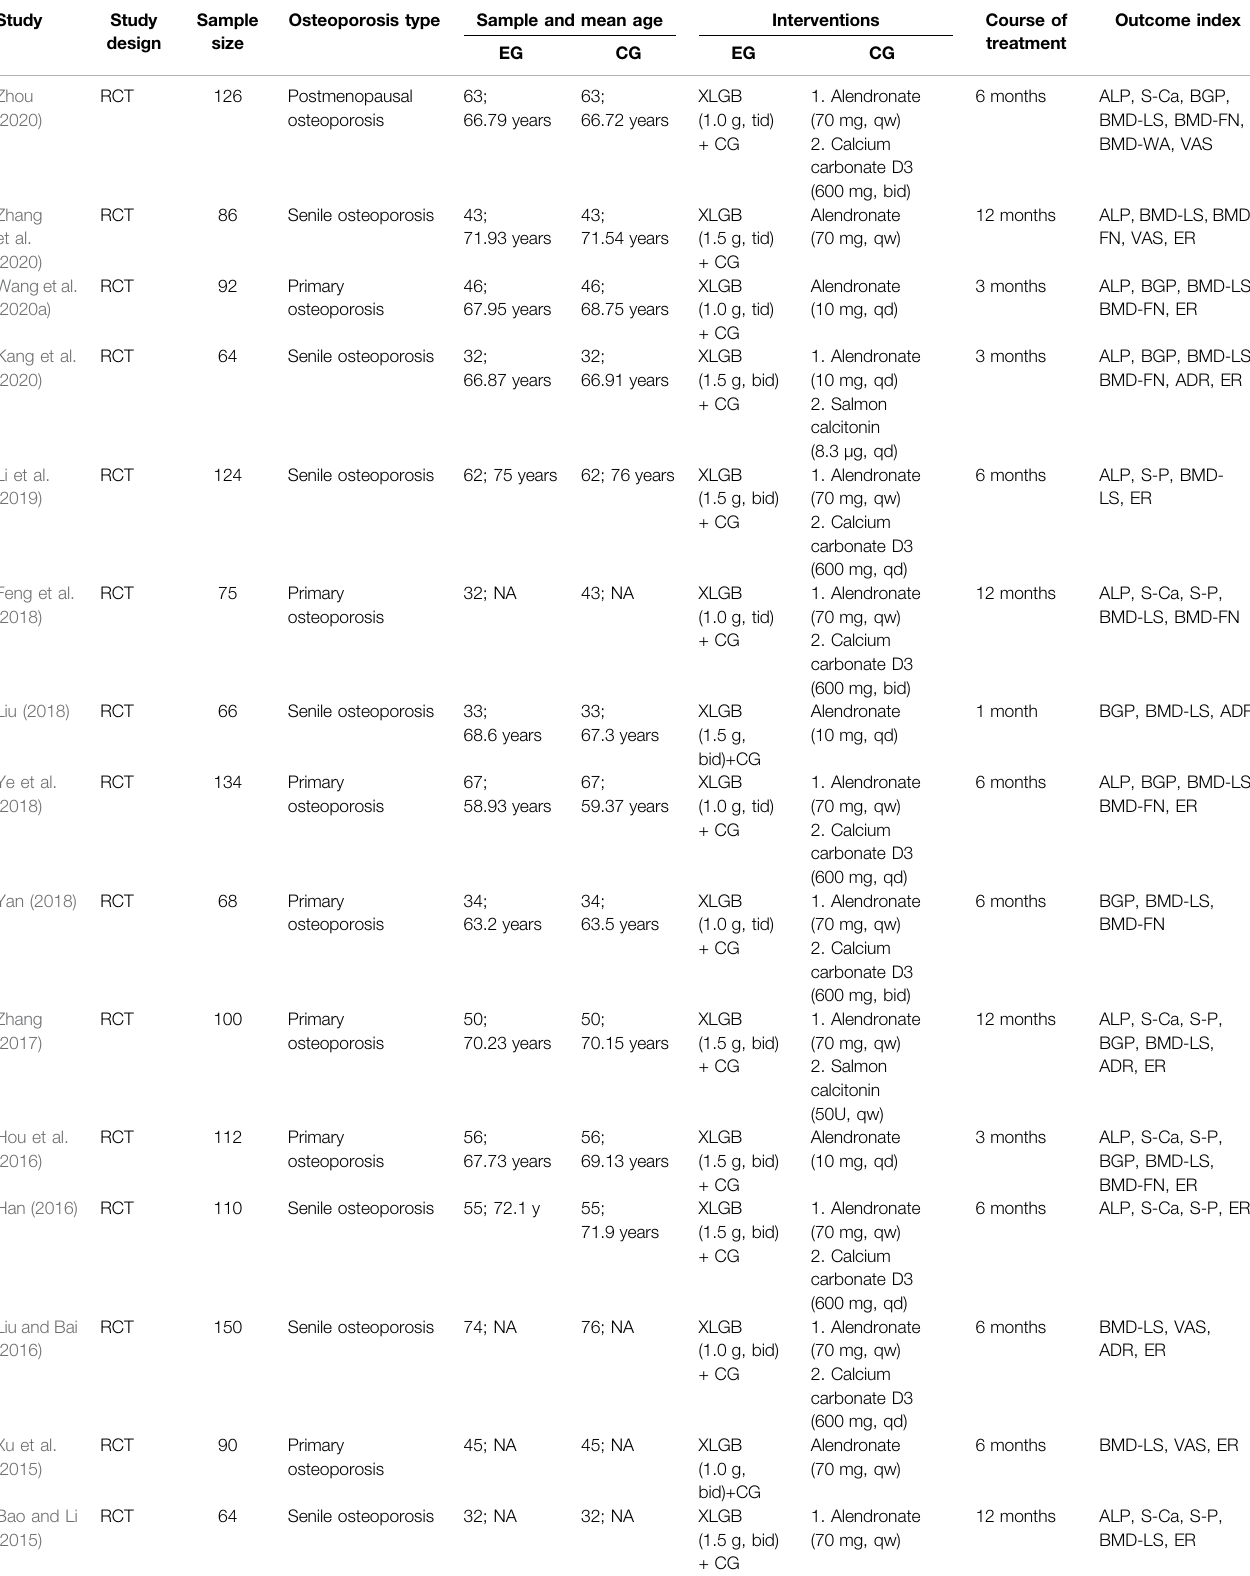
TABLE 1 | The characteristics of the included